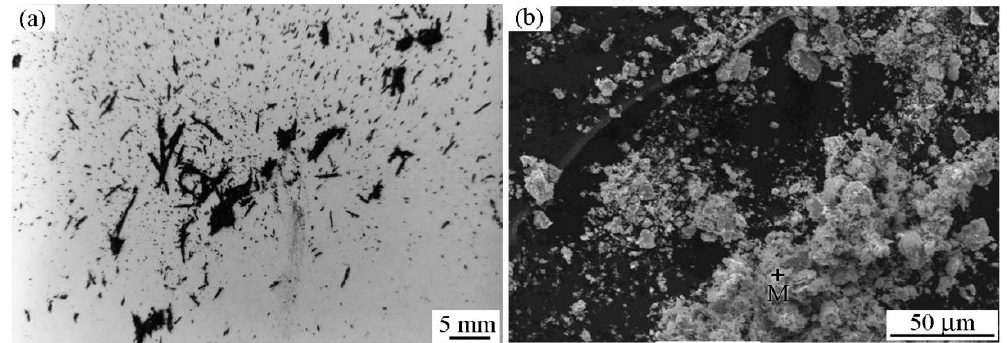
Figure 5. Morphology of wear debris when the RD was not used; H = 26.1 × 10 3 A/m. ( a ) Macro-photograph and ( b ) scanning electron microscope (SEM) image. Table 1. Chemical components of the wear debris (at.%).